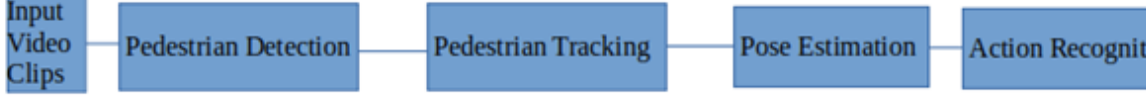
Figure 2. Proposed Pipeline for Footage